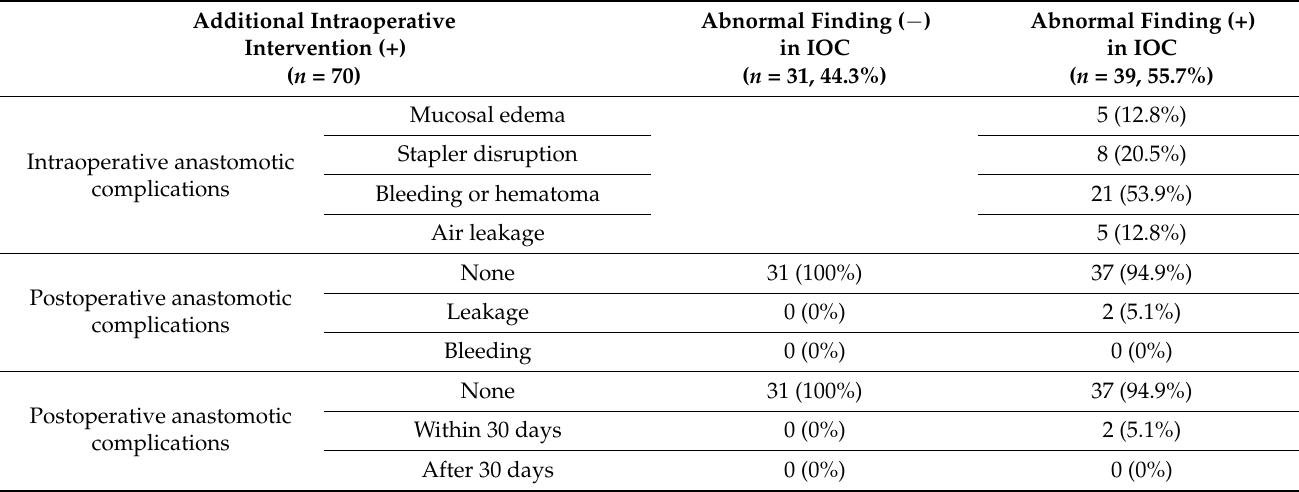
Table 5. IOC findings of intraoperative anastomotic complications and postoperative anasto- motic